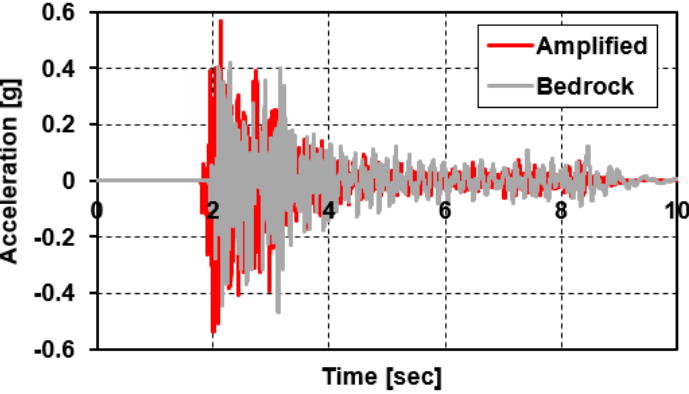
Figure 20. The elaborated accelerograms.